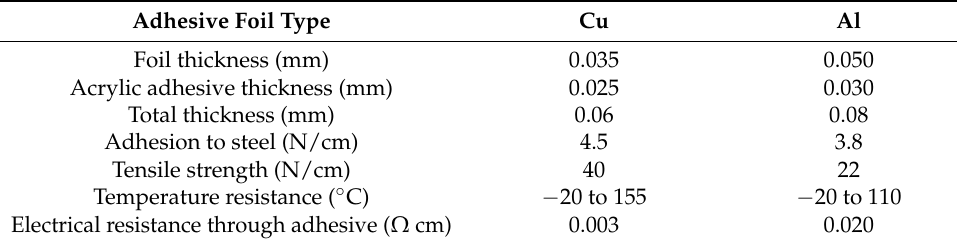
Table 4. Chemical composition of Cu and Al foils.